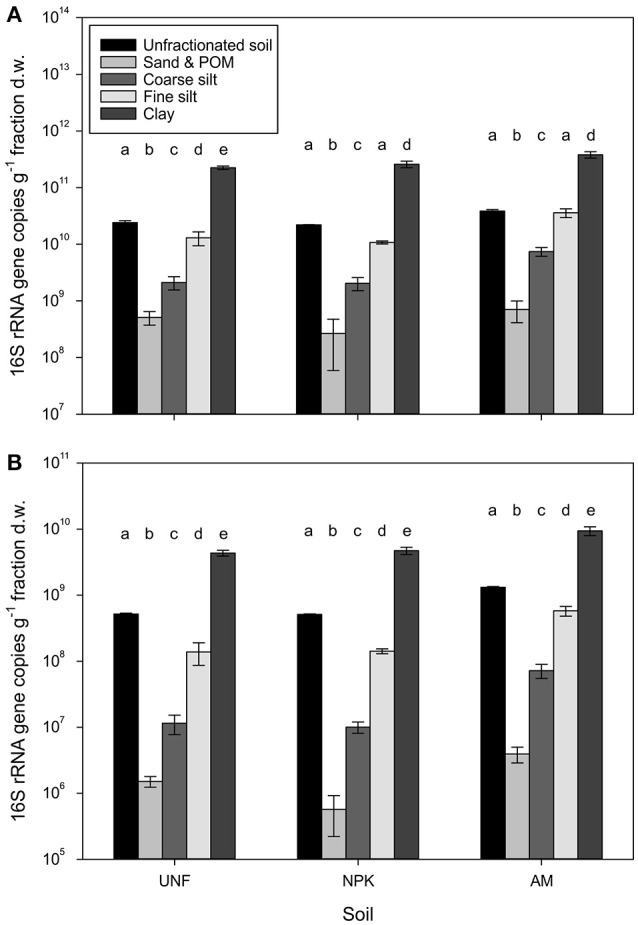
Bacterial (A) and archaeal (B) abundances represented by 16S rRNA gene copy numbers retrieved from three replicates, i.e., unfertilized soil (UNF), mineral fertilized soil (NPK), and animal manured soil (AM). Error bars represent standard deviations of technical triplicates. Different letters indicate significant differences between technical replicates between fractions within each fertilization treatment. The overall p-values between fractions across treatments for bacteria and archaea was <0.001 (F = 512.66) and <0.001 (F = 646.22), respectively.